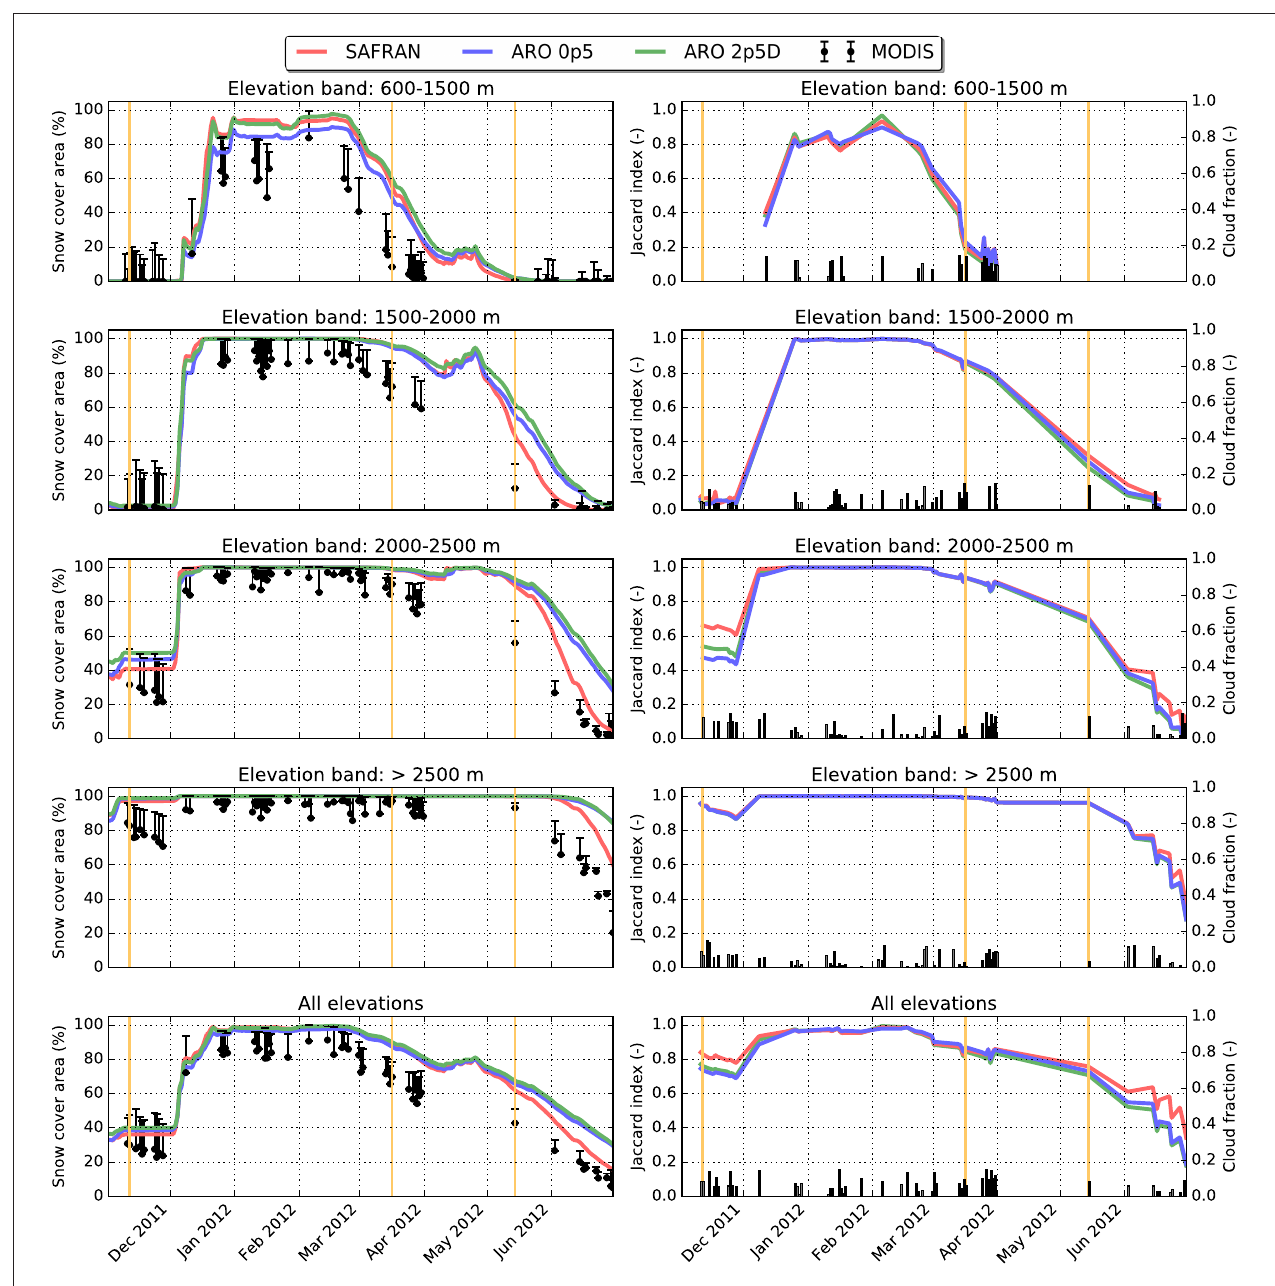
FIGURE 11 | (Left) Temporal evolution of observed and simulated snow cover area for several elevation bands and for all elevations. Vertical error bars for MODIS observations show the uncertainty associated with cloud presence and missing data; (Right) Temporal evolution of Jaccard index for the three Crocus experiments. The vertical bars represent the cloud coverage. Only MODIS images with a cloud cover below 15% were used to compute the Jaccard index. The vertical orange lines on each graph represent the dates shown on Figure 10 .